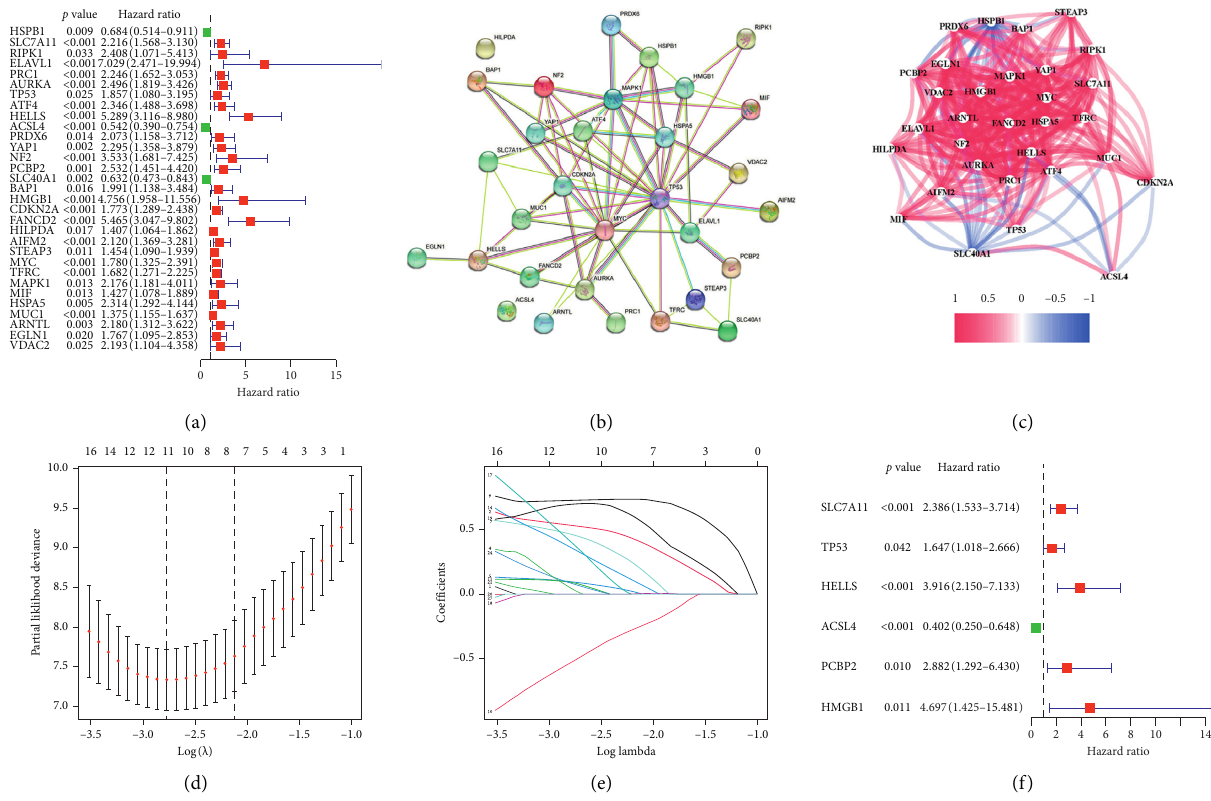
Figure 1: Construction of ferroptosis risk signature. (a) Forest plots showing the results of ferroptosis-related genes associated with OS by univariate Cox regression. (b) PPI network indicating the interactions among the candidate genes from the STRING. (c) The correlation network of candidate genes. (d) Partial likelihood deviance for the lasso regression. (e) Lasso profiles of ferroptosis-related genes. (f) The ferroptosis risk signature developed by multivariate Cox